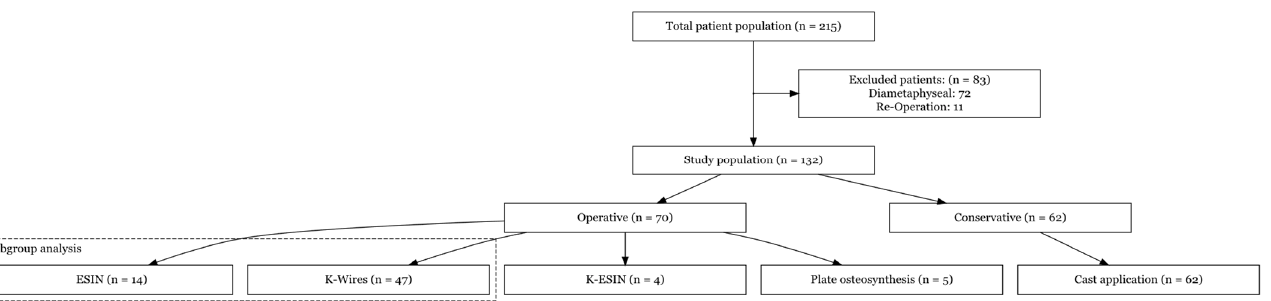
Table 2. Fracture type by mode of injury. N Total